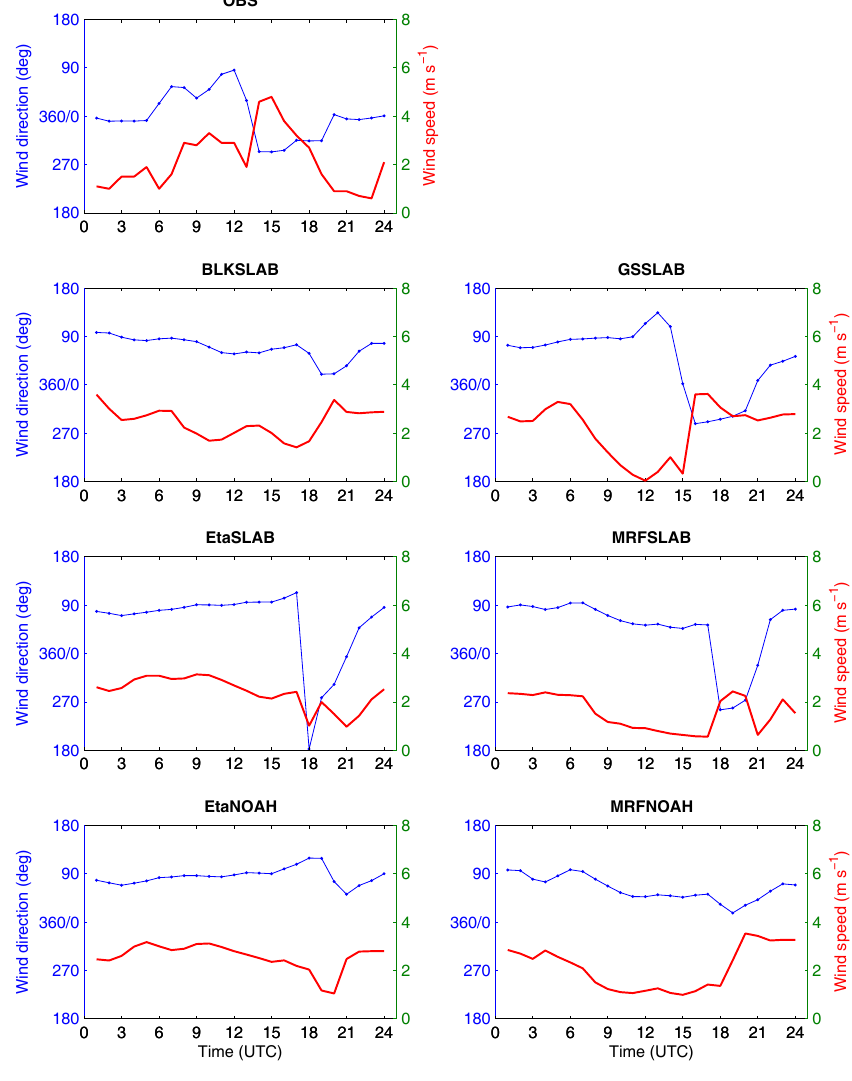
Fig. 8. Same as Fig. 2 but at Tagene